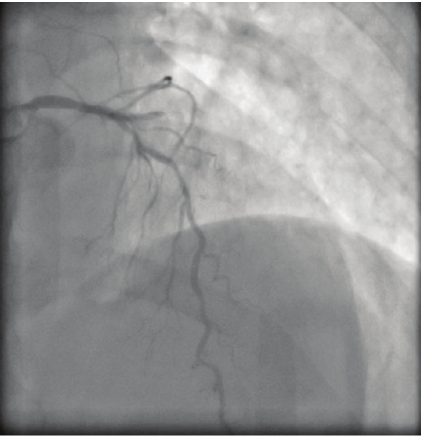
Figure 1: Diffusely diseased LAD with a 70% stenosis in the mid third with an occluded OM1.